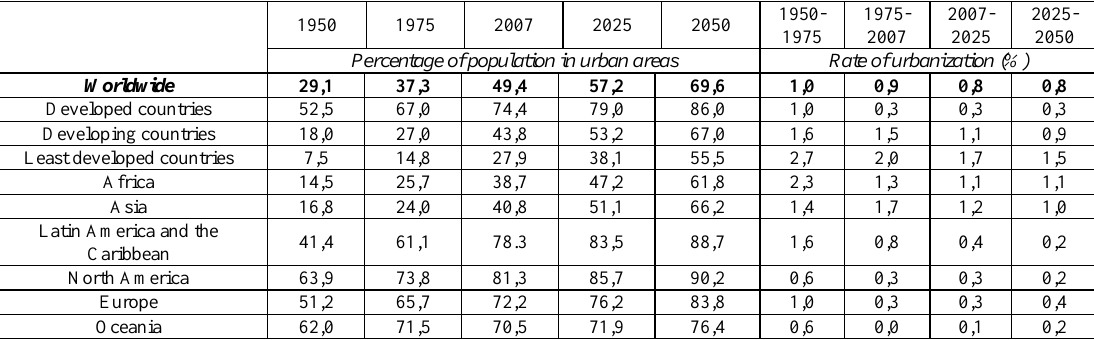
Table 2. Dynamics of urbanization, 1950-2050*